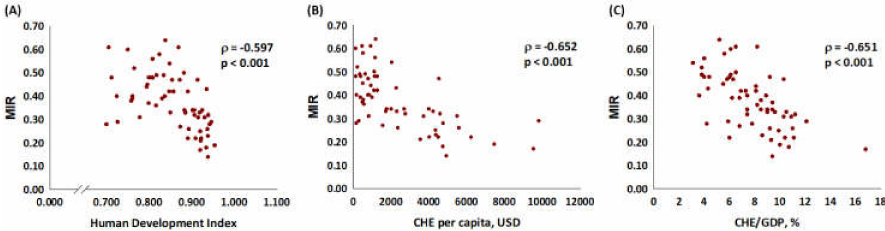
Figure 2. ( A ) HDI, ( B ) CHE per capita, and ( C ) CHE/GDP are significantly associated with the MIR for lip and oral